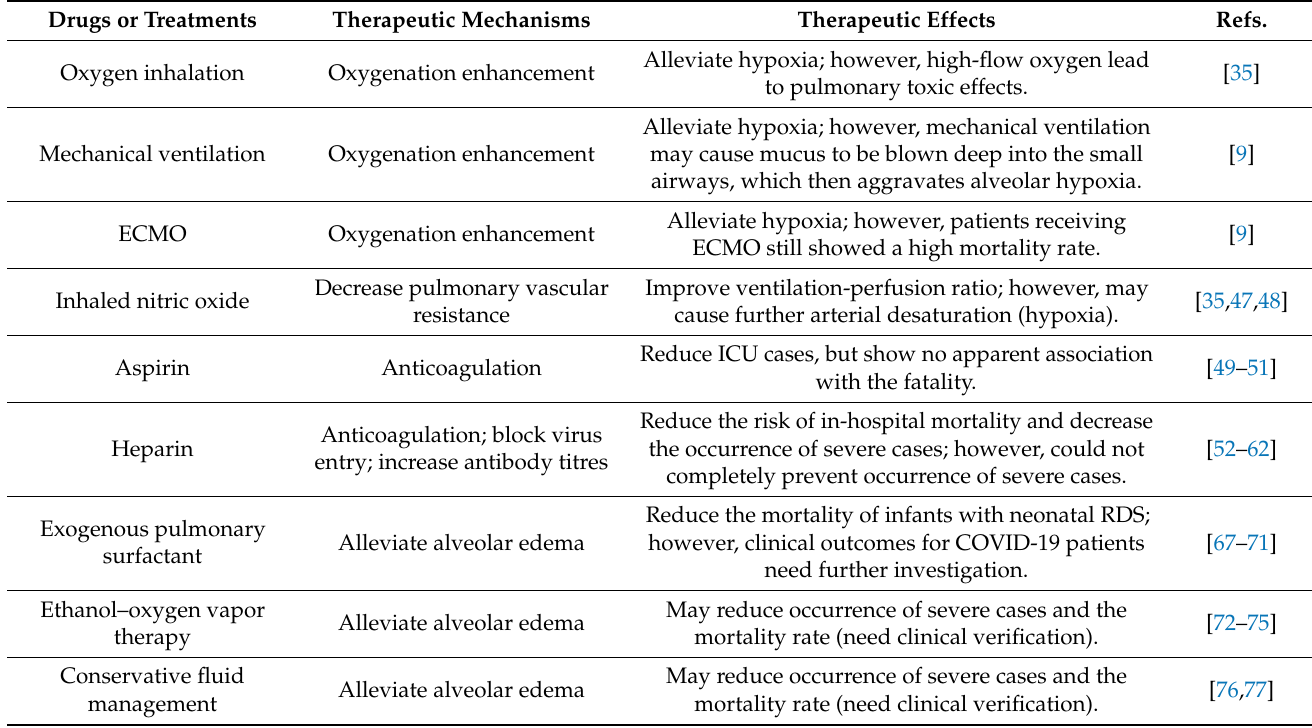
Table 2. Putative drugs and treatments to SARS-CoV-2